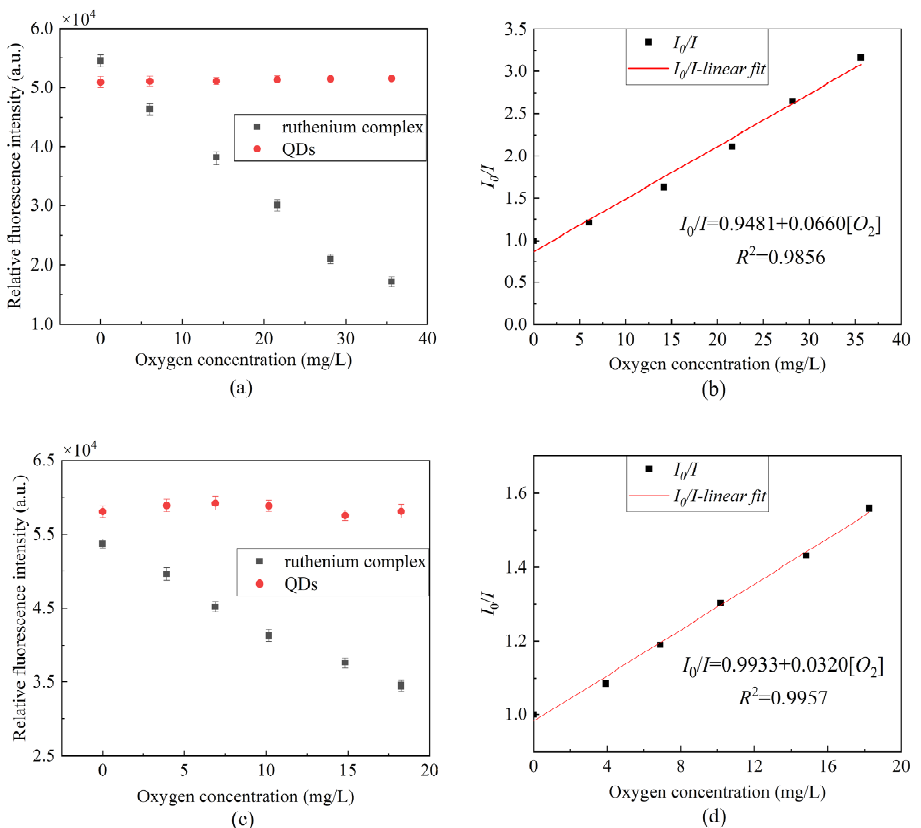
Figure 8. Fluorescence response at different oxygen concentrations ( a ) peak fluorescence intensity of ruthenium complex and QDs in gaseous oxygen, ( b ) Stern–Volmer equation curve of gaseous oxygen in the presence of mixed ruthenium complex and QDs, ( c ) peak fluorescence intensity of ruthenium complex and QDs in aqueous solution, ( d ) Stern–Volmer equation curve of aqueous solution in the presence of mixed ruthenium complex and QDs.